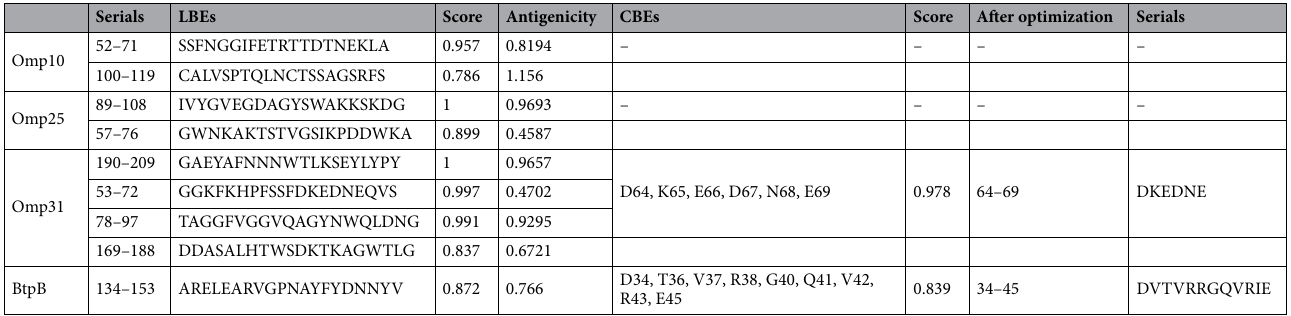
Table 2. List of the final selected LB and CB epitopes.